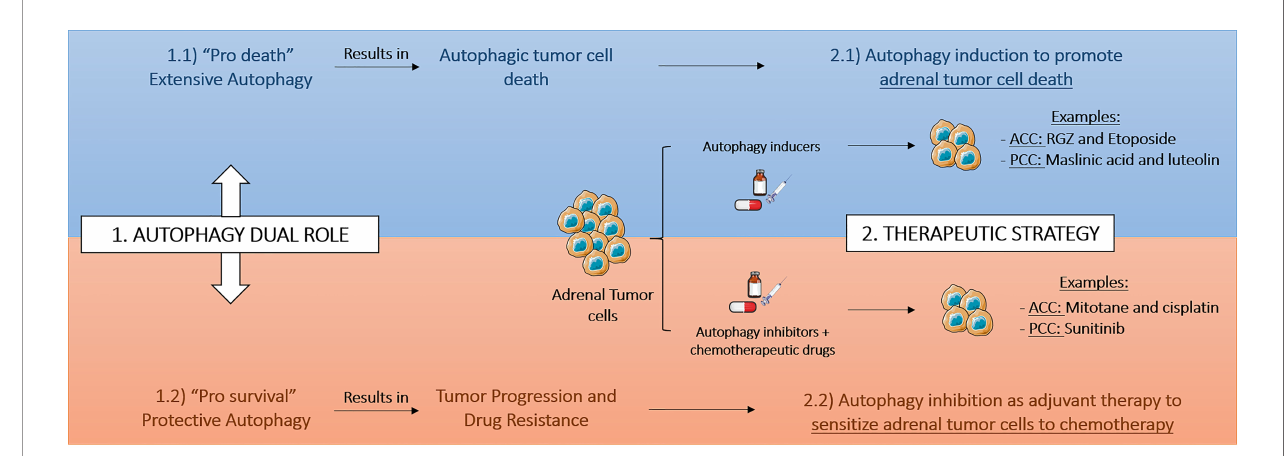
FIGURE 2 | Therapeutic strategies based on autophagy modulation in adrenal tumors. The therapeutic interest and consequently the therapeutic strategy based on autophagy modulation in adrenocortical cancer (ACC) and pheochromocytoma (PCC) depends on pro-survival or pro-death tumoral context. RGZ,